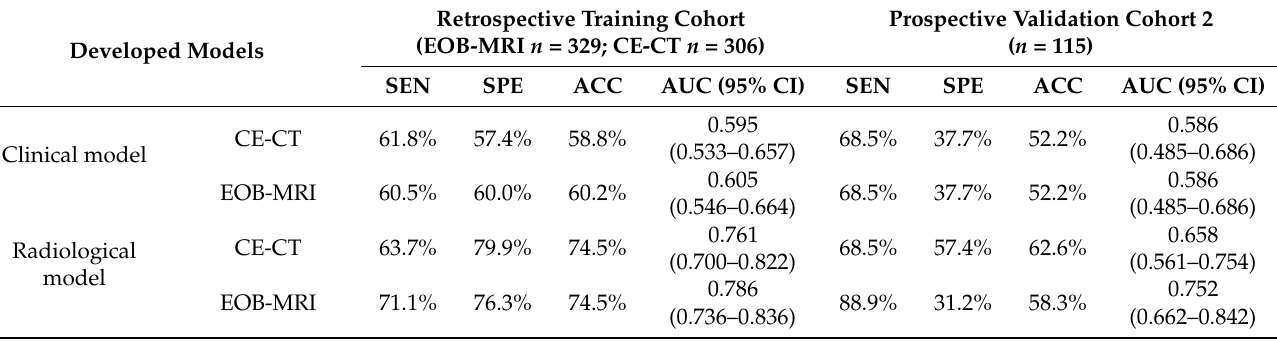
Table 3. Predictive performances of the developed